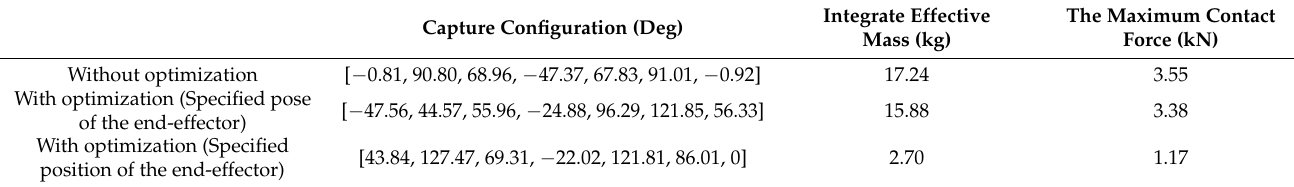
Figure 15. Capture process of 7-dof space robot with maximum-contact-force optimization and the constraint of specified position of the end-effector. Table 7. Simulation comparison results of 7-dof space